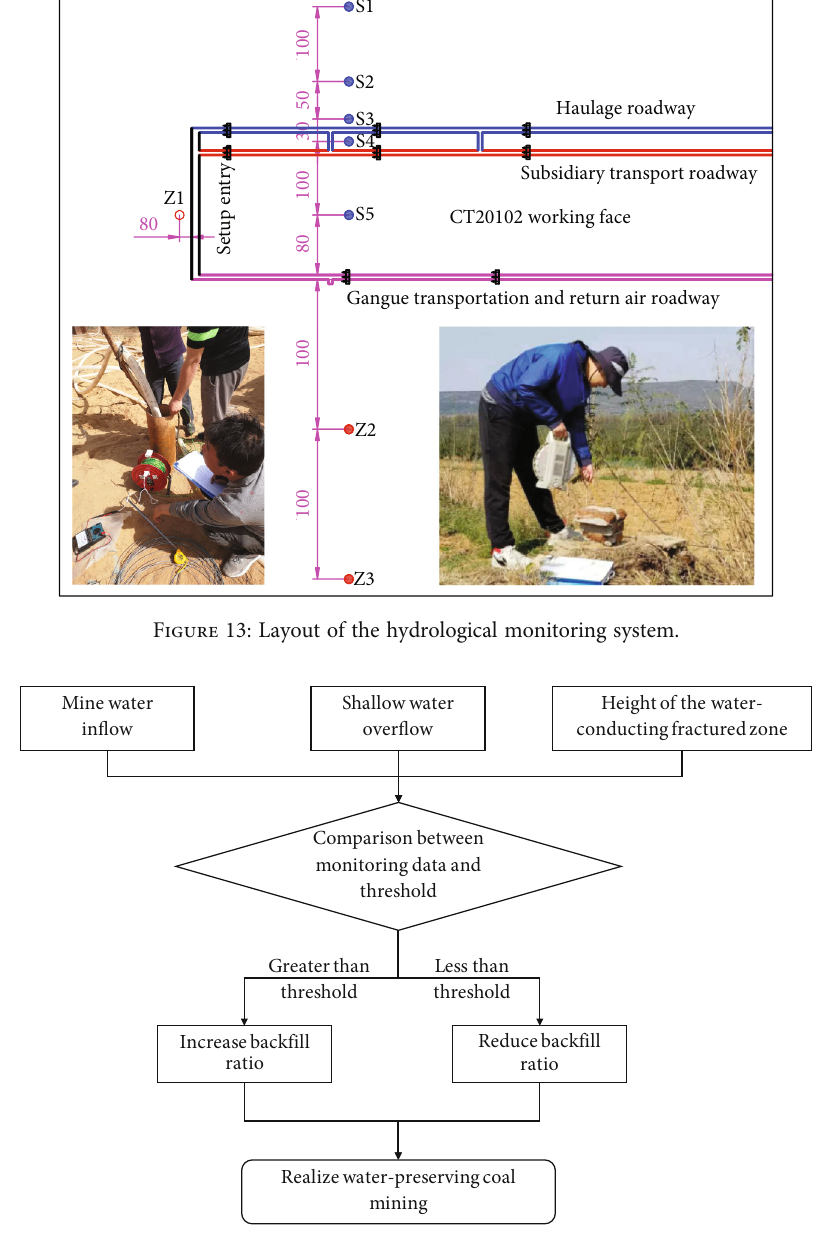
Figure 14: Feedback adjustment system of the back fi ll